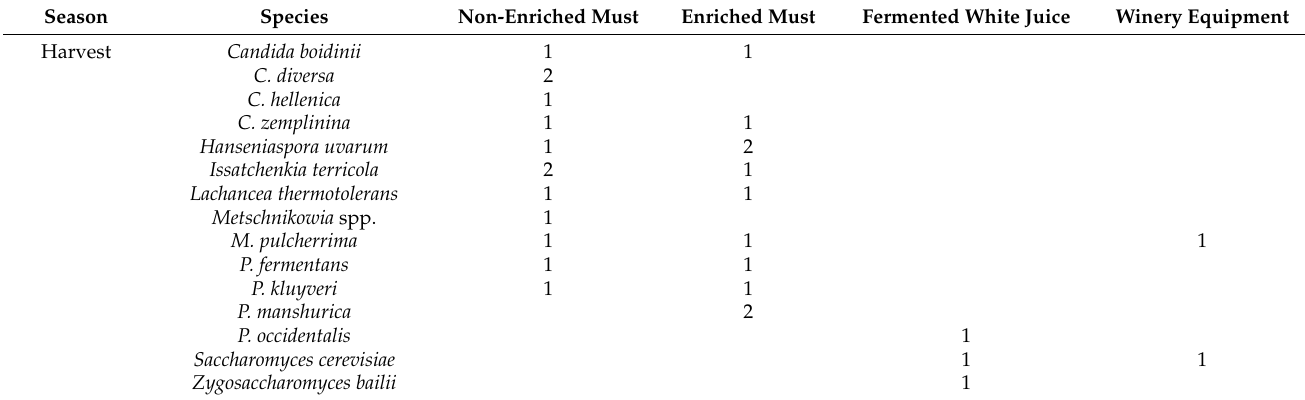
Table 3. Number of samples with ascomycetous species recovered from the winery.